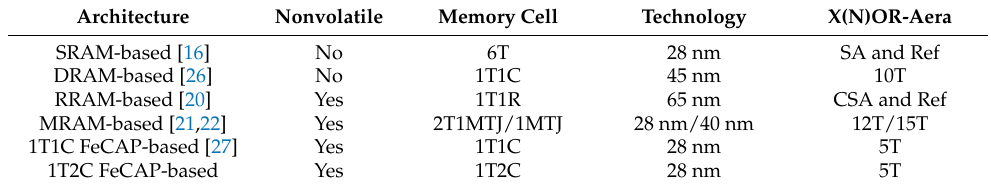
Table 4. Performance comparison of several in-memory X(N)OR logic implementation